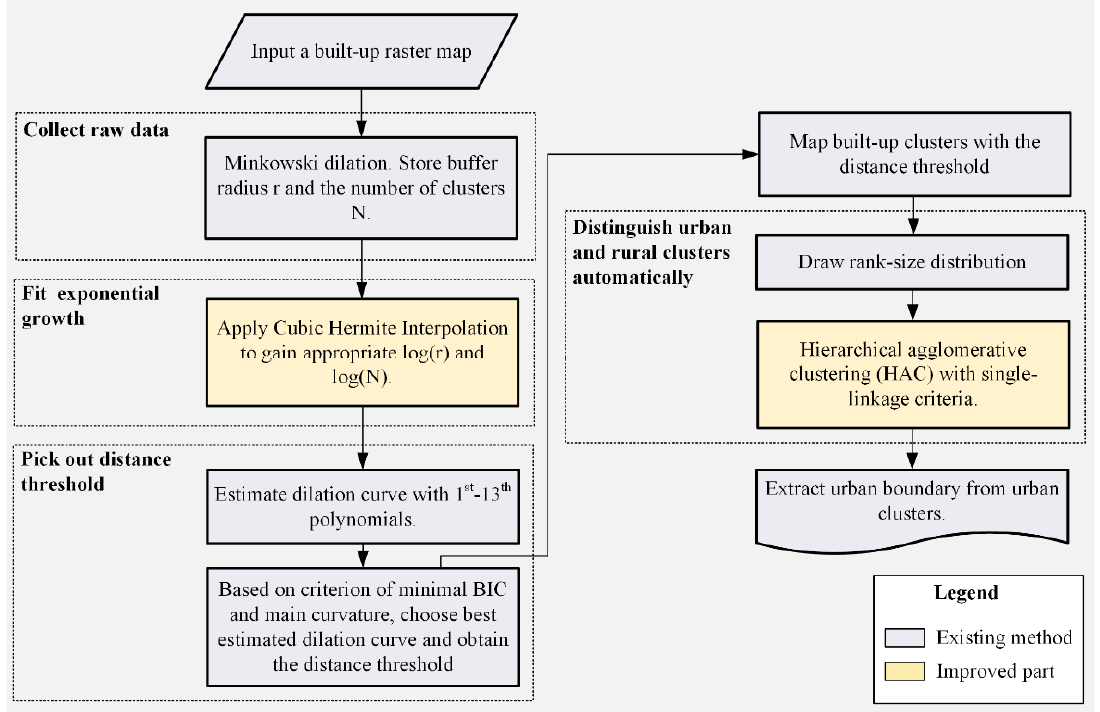
Figure 5. Flowchart of urban boundary delineation.